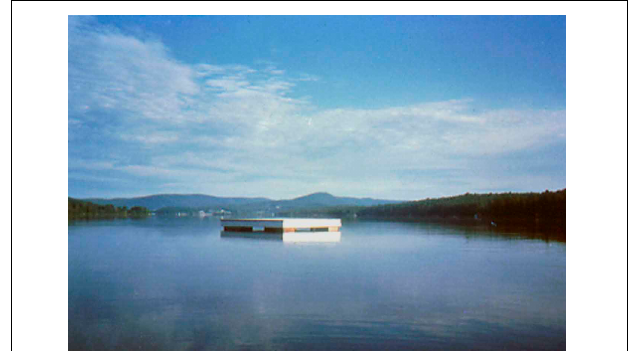
FIGURE 1 | Photograph of a swimming raft with sunlight illumination on the right and skylight illumination on the left. Observers report sensations that are lighter and more yellow in the sun; and darker and more blue in skylight. Observers also report that the two sides of the float are perceived to have the same white paint, despite their different appearances.